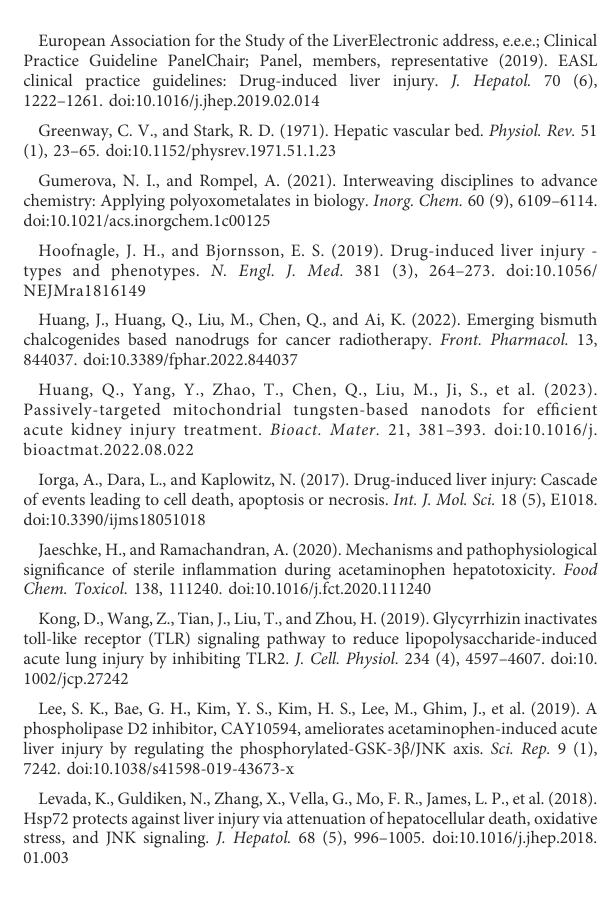
SUPPLEMENTARY FIGURE S1 In vitro cytotoxicity of EGM NPs towards L02 cells after incubation for 24 h and 48 h. Data represent means ± S.D. from six independent replicates. SUPPLEMENTARY FIGURE S2 HE staining of major organs (heart, liver, spleen, lung, kidney) of normal mice after injection with PBS or EGM NPs for 30